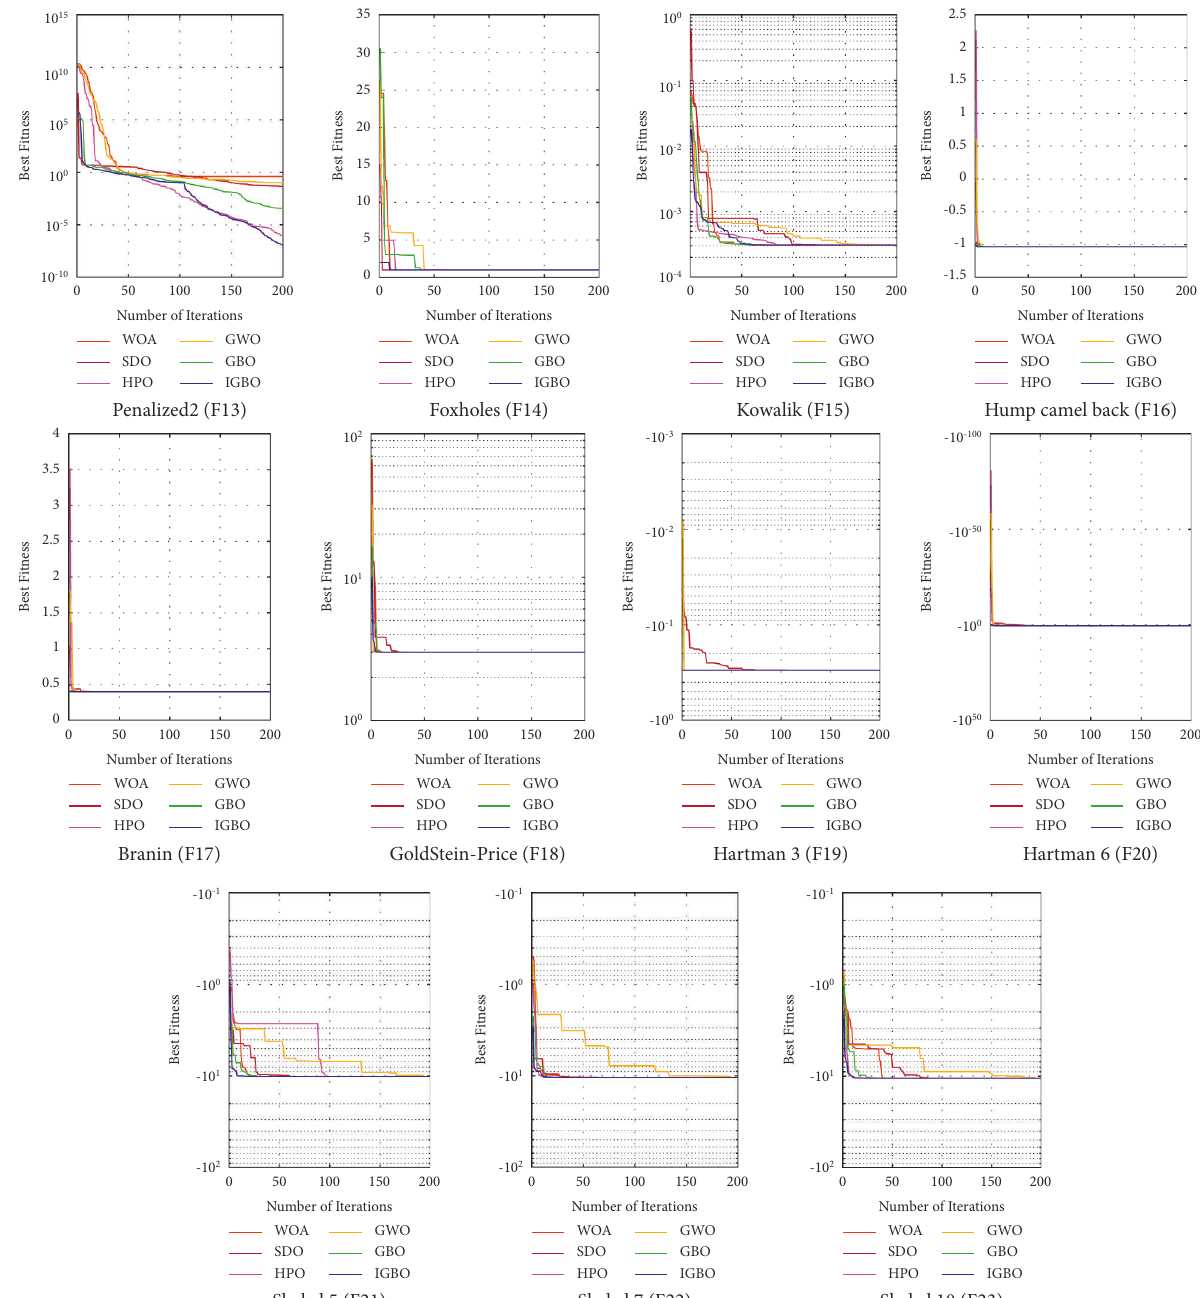
Figure 4: The convergence curves of all optimization algorithms for 23 benchmark